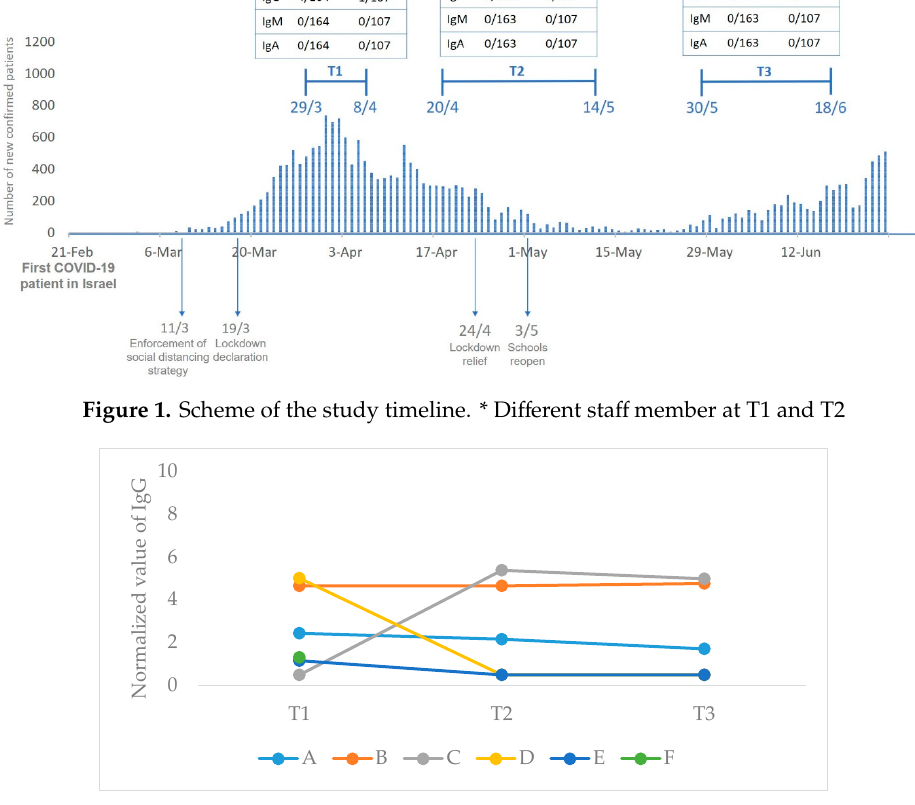
Table 2. Description of COVID19 serology-positive patients.